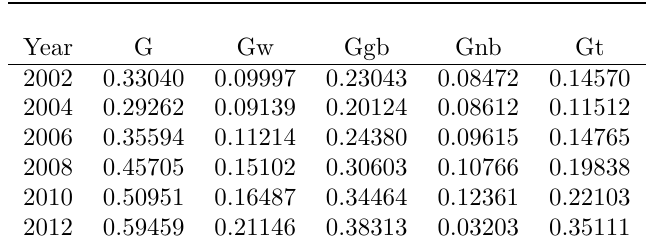
Gini index decomposition of wealth